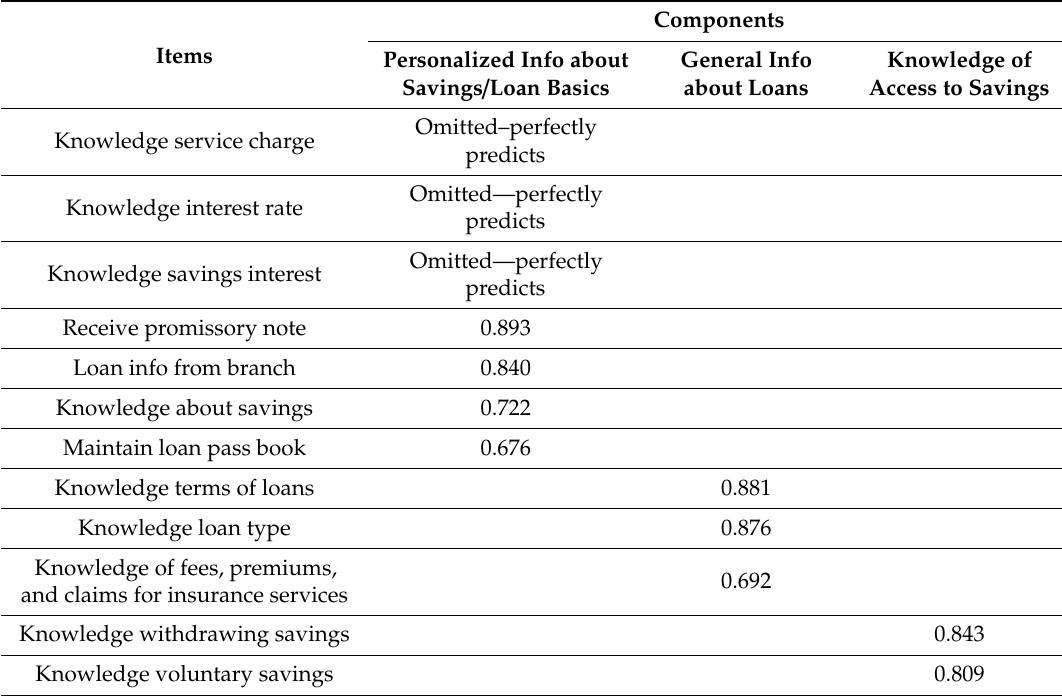
Table 3. Factor analysis (N =